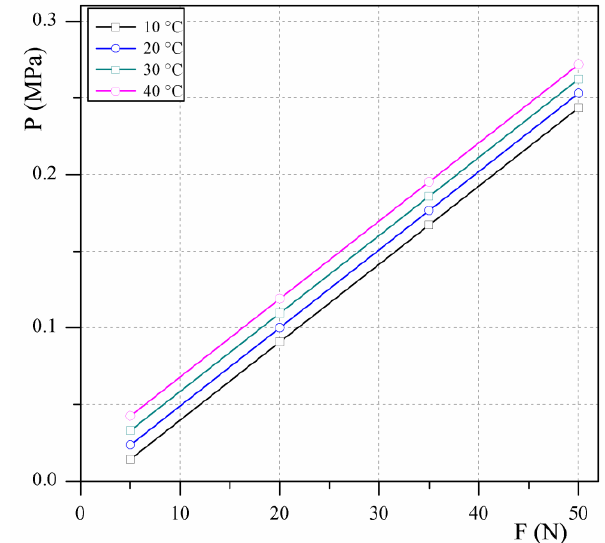
Figure 3. Pressure inside the hydraulic load cell at various loads and temperatures for a metallic bellows of wall thickness 0.127